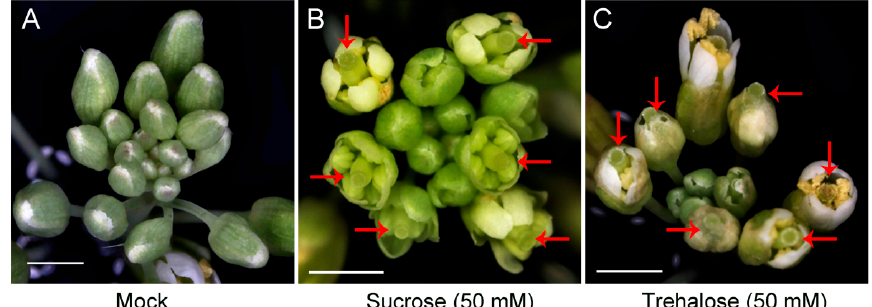
Figure 6. Applications of sucrose and trehalose inhibit development of perianth and stamen filaments development in Arabidopsis . Inflorescences treated with mock ( A ), with 50 mM sucrose ( B ), and with 50 mM trehalose ( C ). Red arrows indicate pistils. The bars represent 1.0 mm.